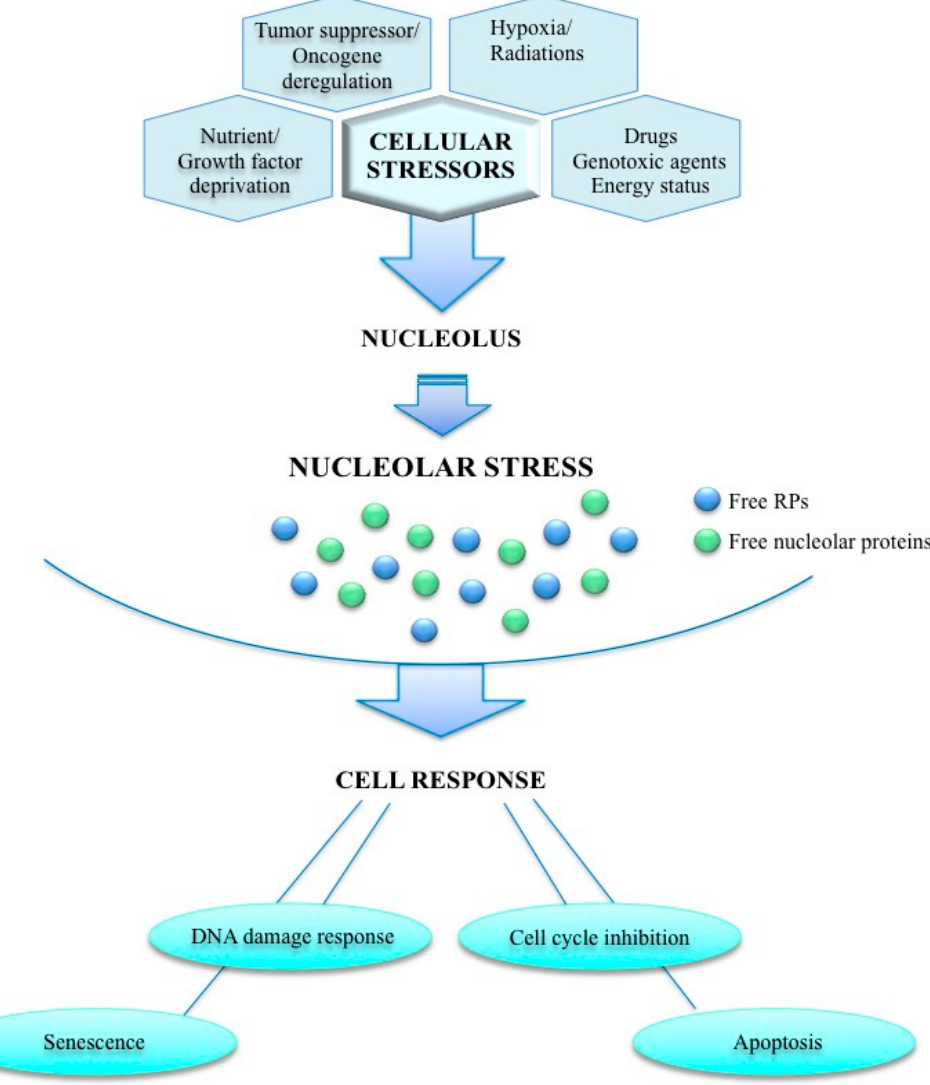
Figure 1. The nucleolar stress pathway. Nucleolus can be exposed to a variety of cellular stressors that disrupt ribosome biogenesis activating a complex cellular response namely “nucleolar stress”. This stress pathway is mediated by several ribosomal proteins RPs and/or nucleolar proteins and its activation results in cell cycle arrest, apoptosis, DNA damage and senescence. Dysregulation of this response is known to contribute to the development of cancer.